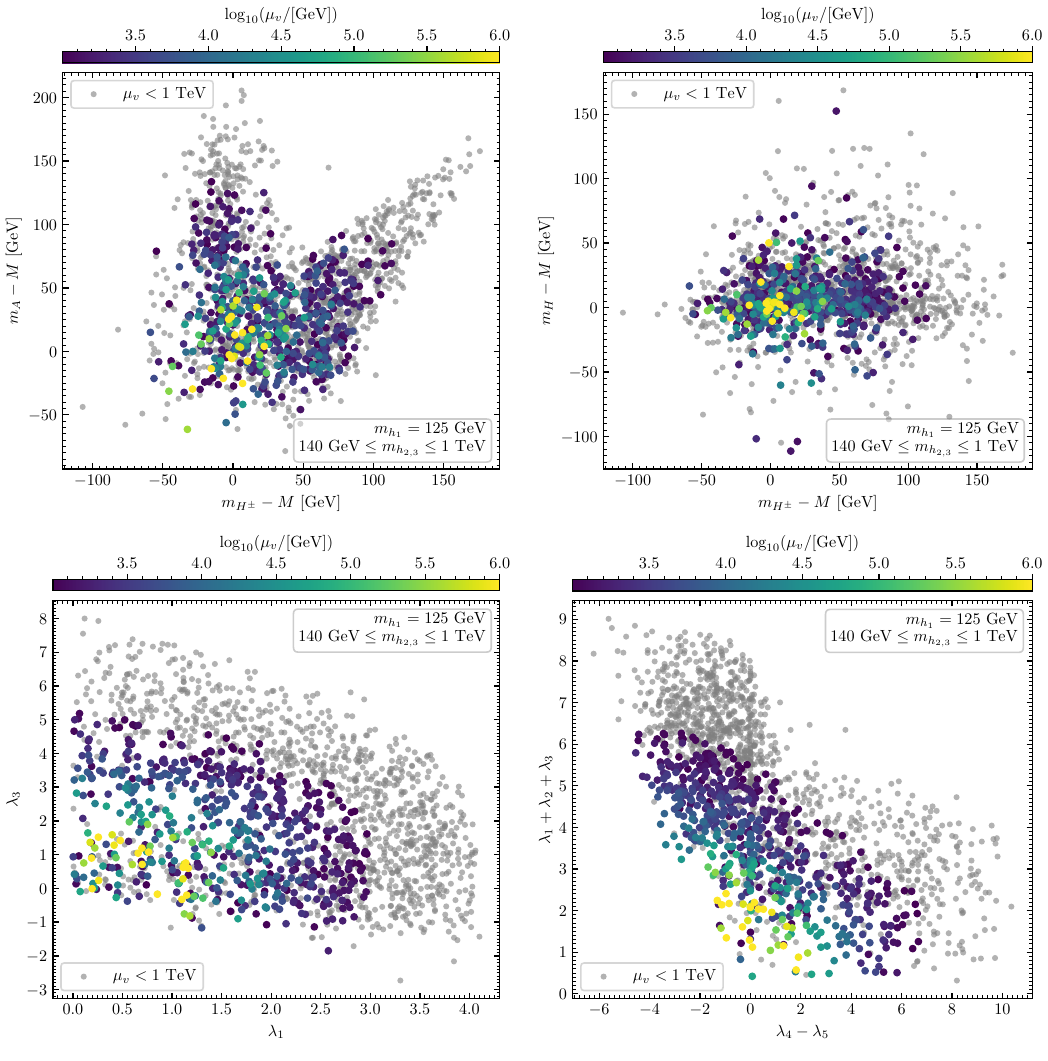
Figure 1 . Top row: m A − M (left) and m H − M (right) in dependence of m − M , where H ± m H = m h or m H = m h depending on whether Σ h < Σ h or vice versa. Bottom row: λ 3 in 2 2 2 3 dependence of λ 1 (left) and λ 1 + λ 2 + λ 3 in dependence of λ 4 − λ 5 (right). The colour coding indicates the value of µ v . Also shown in grey are discarded parameter points with µ v < 1 TeV